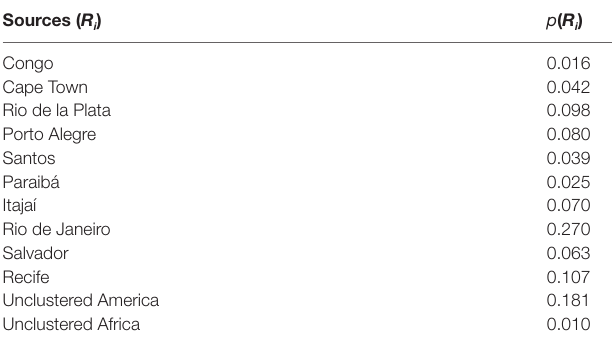
TABLE 1 | Prior probability p (R i ) of floating plastic being released in a specific cluster